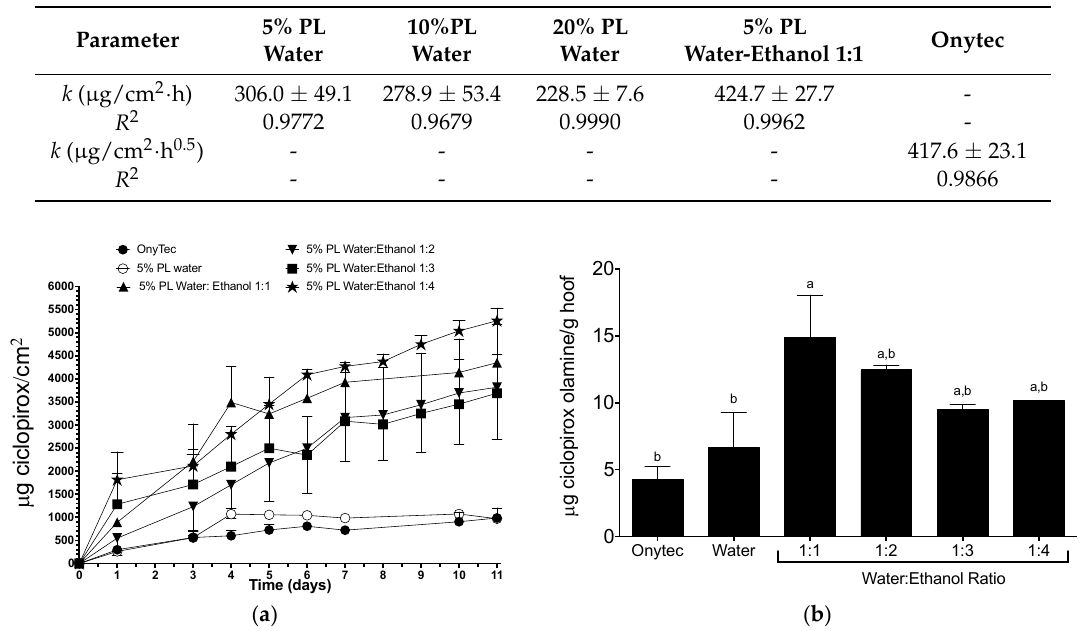
Table 4. Result of adjusting the results of the release of ciclopirox from lacquers to zero order and diffusion kinetics. (Average ± standard error, n = 3).